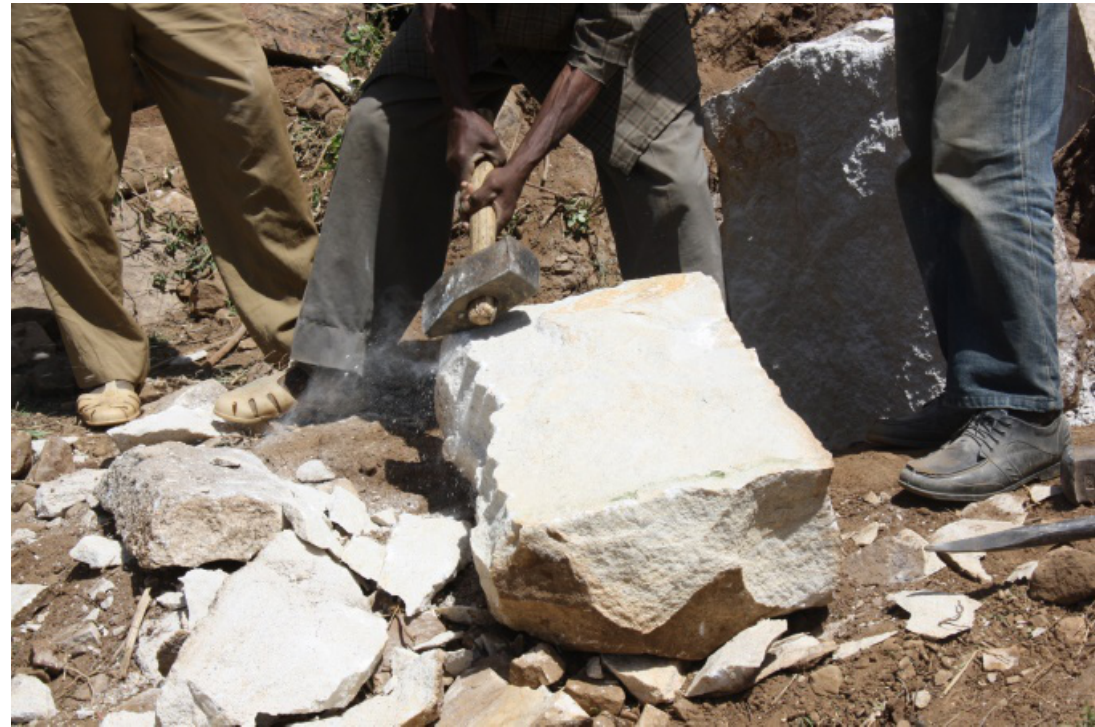
Figure 9. Haleka Tehwoelde Brahn Beyene here is trimming large flakes.